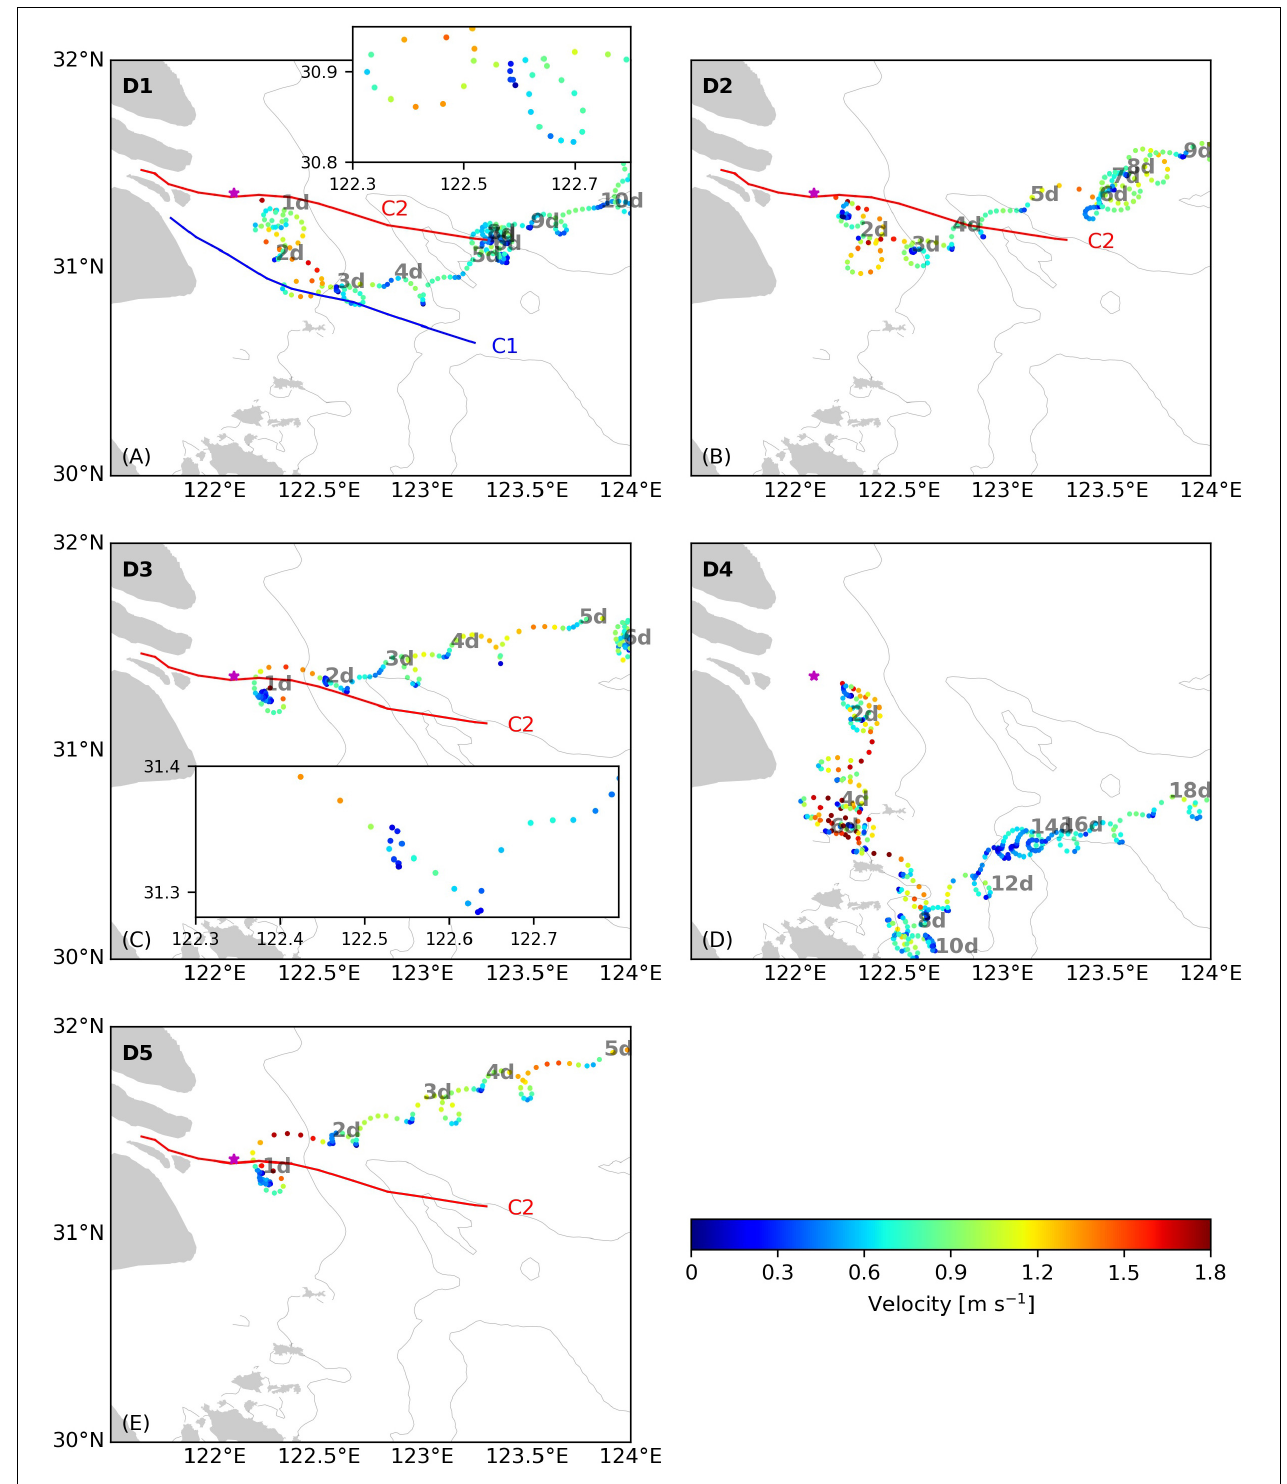
FIGURE 6 | Trajectories of Drifter (A) D1, (B) D2, (C) D3, (D) D4, and (E) D5 released near the Changjiang river mouth in the coastal area west of 124 ◦ E. The elapsed time (in days) since the release are labeled along the trajectories. Color represents the velocity of the drifters. The thin, gray lines are the 20, 50, and 60 m isobaths. In (A,C) , the trajectories in the section of 122.3–122.8 ◦ E are enlarged in an embedded panel to show the longer retention time of the drifters near 122.6 ◦ E (A) and in 122.5–122.6 ◦ E (C) which indicate surface flow convergence.